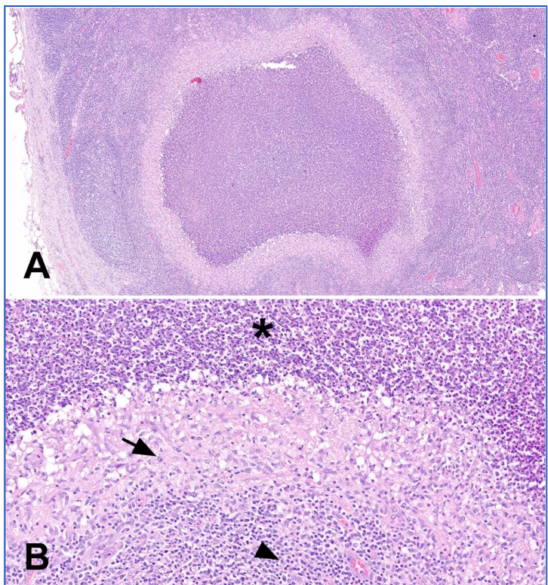
Figure 5. Histologic features of cat-scratch disease. ( A ) Suppurative granuloma characterized by a central area of necrosis surrounded by palisading histiocytes and fibroblasts (haematoxylin-eosin, magnification 4 × ). ( B ) Higher magnification showing polymorphonuclear leukocytes (asterisk), pal- isading histiocytes (arrow) and lymphocytes (arrowhead) (haematoxylin-eosin, magnification 20 ×